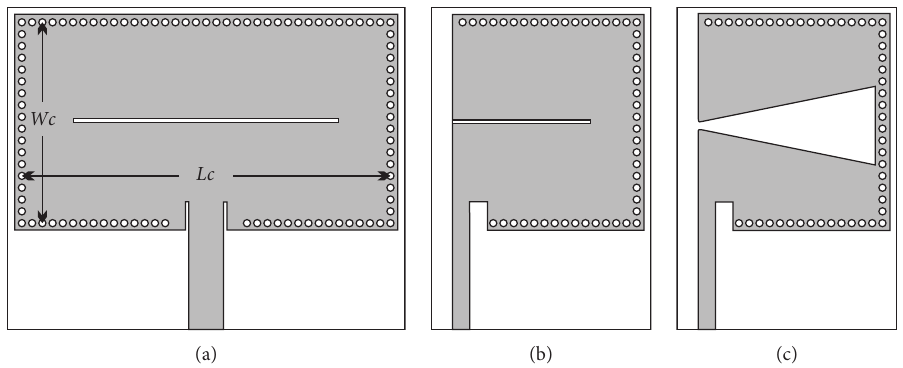
Figure 2: Design evolution of an SIW-CBS antenna for miniaturization and bandwidth enhancement: (a) FMSIW-CBS antenna with a single resonance and (b, c) HMSIW-CBS antenna with hybrid